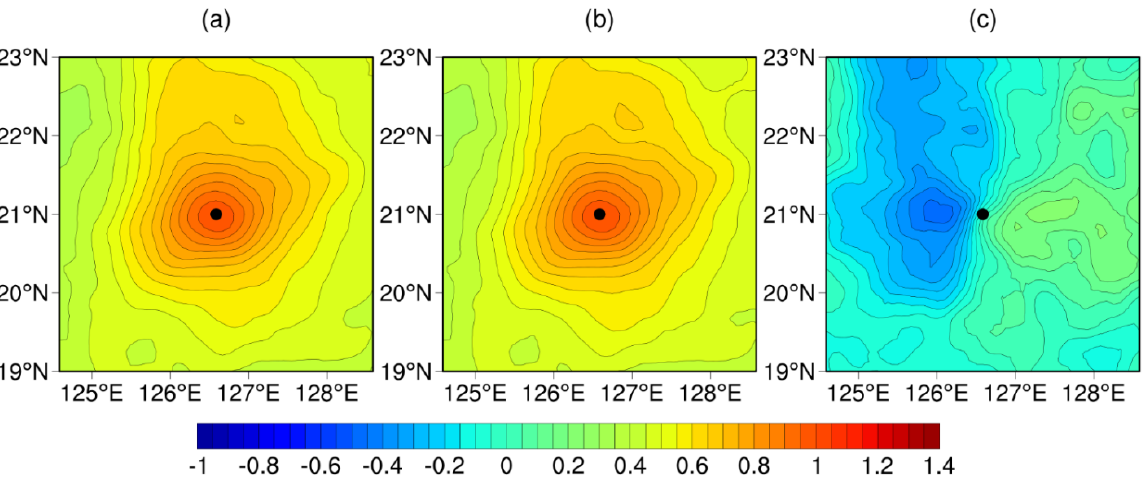
Figure 7. Distribution of the gain for group C on 1 January 2015, and the black dot in the figure is the observation point. ( a ) Kalman gain K at moment t in the EnOI scheme; ( b ) Kalman gain K 0 at moment t in the EnOS scheme; ( c ) gain K 1 acting at moment t in the EnOS scheme at historical moment t − 1 .